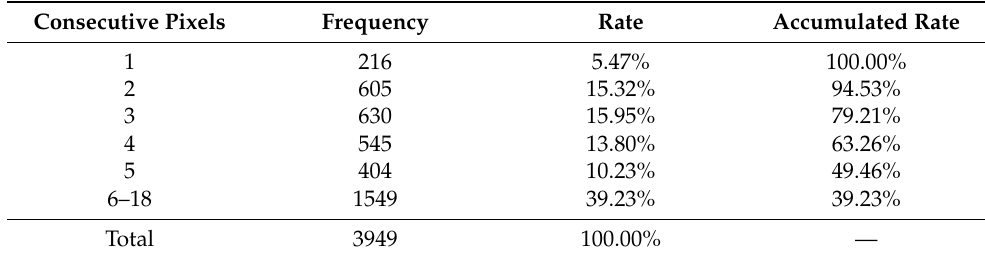
Table 2. Index consecutiveness of one-pixel attacks.